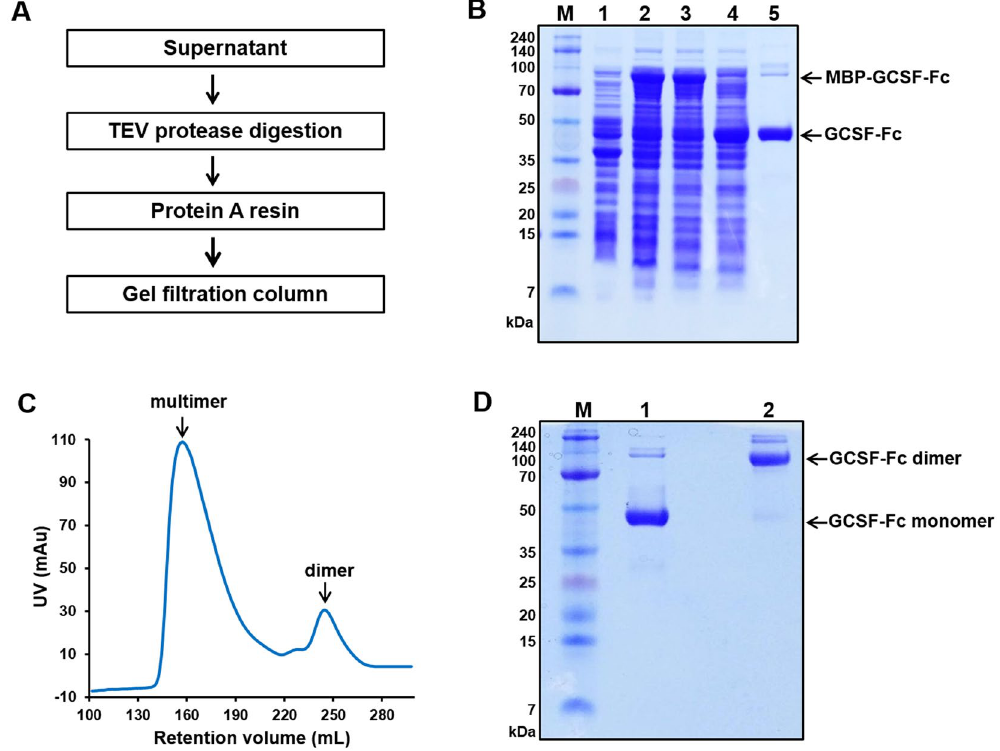
Figure 2. Purification of GCSF-Fc from E . coli . ( A ) Schematic overview of the GCSF-Fc purification process using protein A resin and gel filtration chromatography. ( B ) SDS-PAGE (10% Tris-tricine gel) analysis of GCSF-Fc through different purification steps. M, molecular weight marker; lane 1, total cell extract before IPTG induction; lane 2, total cell extract after IPTG induction; lane 3, soluble fraction after cell homogenization; lane 4, MBP-GCSF-Fc fusion protein was cleaved by TEV protease; lane 5, final GCSF-Fc after purifying by protein A resin and gel filtration column. The arrows indicate positions of fusion MBP-GCSF-Fc (87.8 kDa) and GCSF-Fc (43.8 kDa). ( C ) Chromatogram of superdex 200 26/60 gel filtration column after protein A resin step to separate homodimers from multimers. GCSF-Fc dimers were collected from 235 mL to 270 mL of retention volume. ( D ) SDS-PAGE of GCSF-Fc under reducing and non-reducing condition. Lane 1, reducing GCSF-Fc (43.8 kDa), lane 2, non-reducing GCSF-Fc shows the homodimer with the size of 87.6